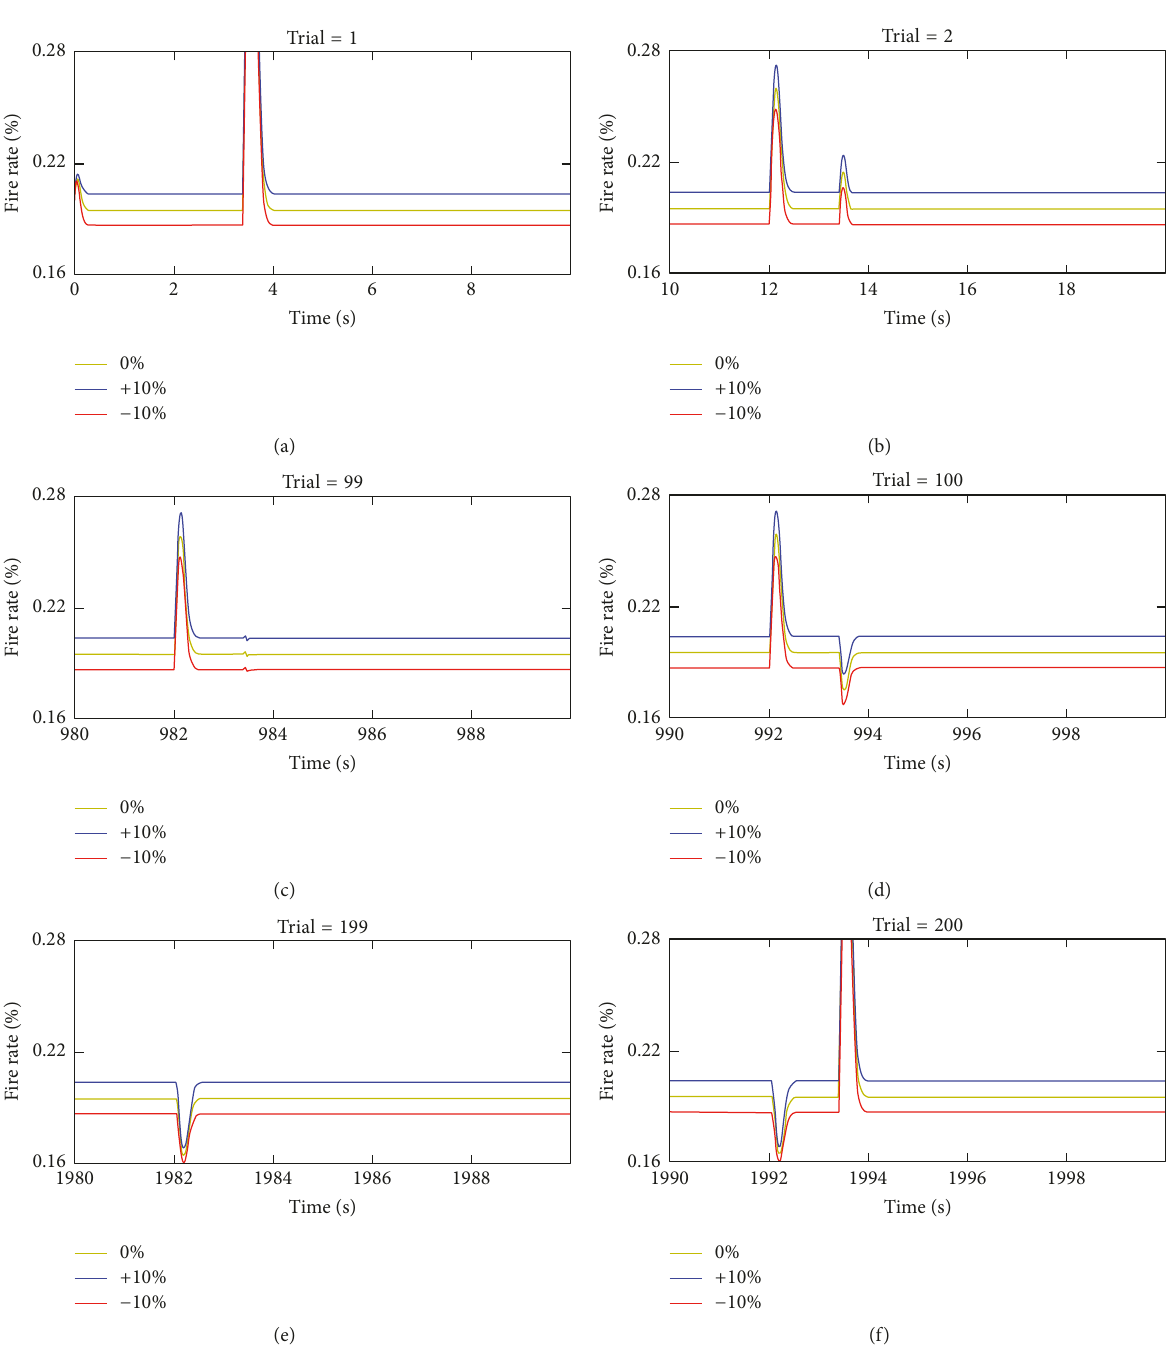
excites DA, while striosome-VTA/SNc pathway inhibits